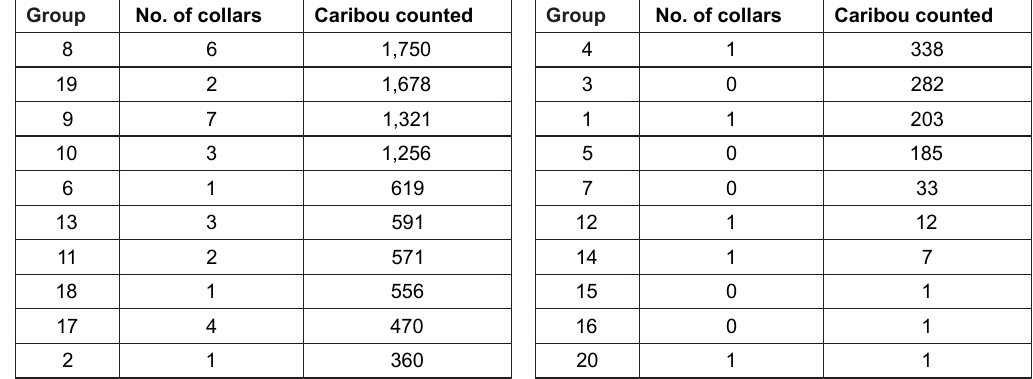
Table 7. Field data for the Bluenose-West 2005 post calving